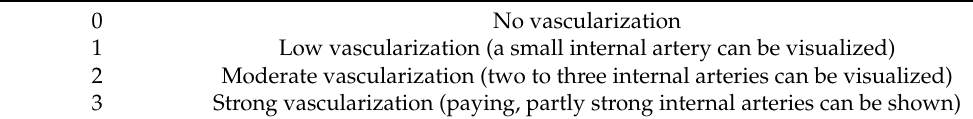
Table 1. Classification of the tumor vascularization levels on CDFI [9]. 0 No vascularization 1 Low vascularization (a small internal artery can be visualized) 2 Moderate vascularization (two to three internal arteries can be visualized) 3 Strong vascularization (paying, partly strong internal arteries can be